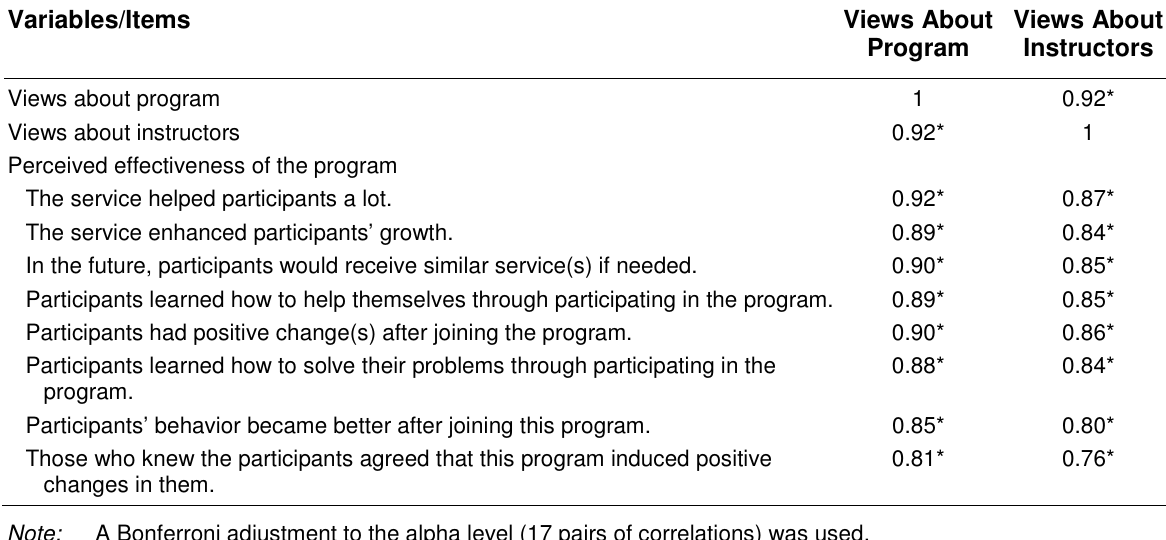
Intercorrelations Among Domains in Subjective Outcome Evaluation